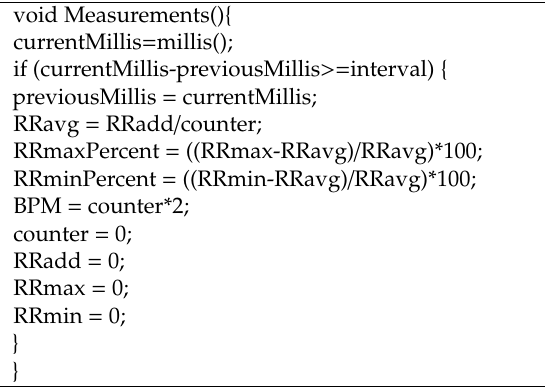
Figure 7. RR interval (data obtained using Bitalino ECG sensor and Arduino microcontroller). Table 1. The Measurement subroutine used to calculate the